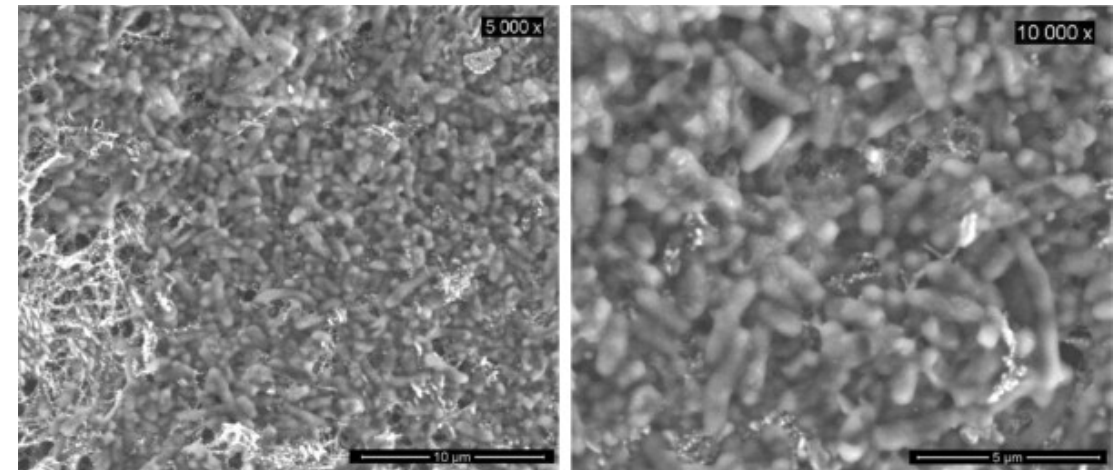
Figure 7. Scanning electron microscope images of electro-activated Escherichia coli K12. Reprinted from [202], with permission from Elsevier.